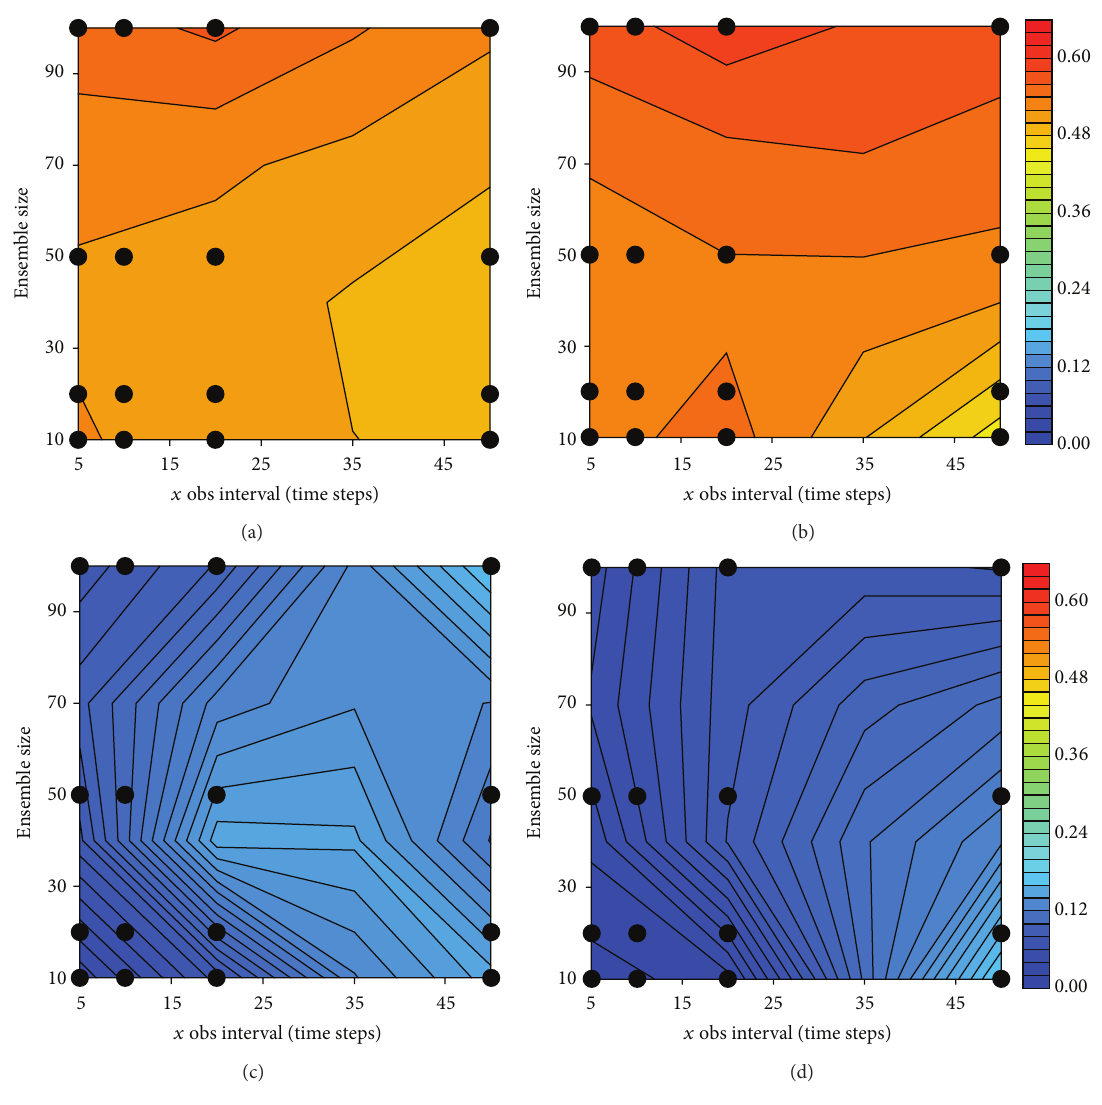
Figure 8: Same as Figure 4 but for the EnKF